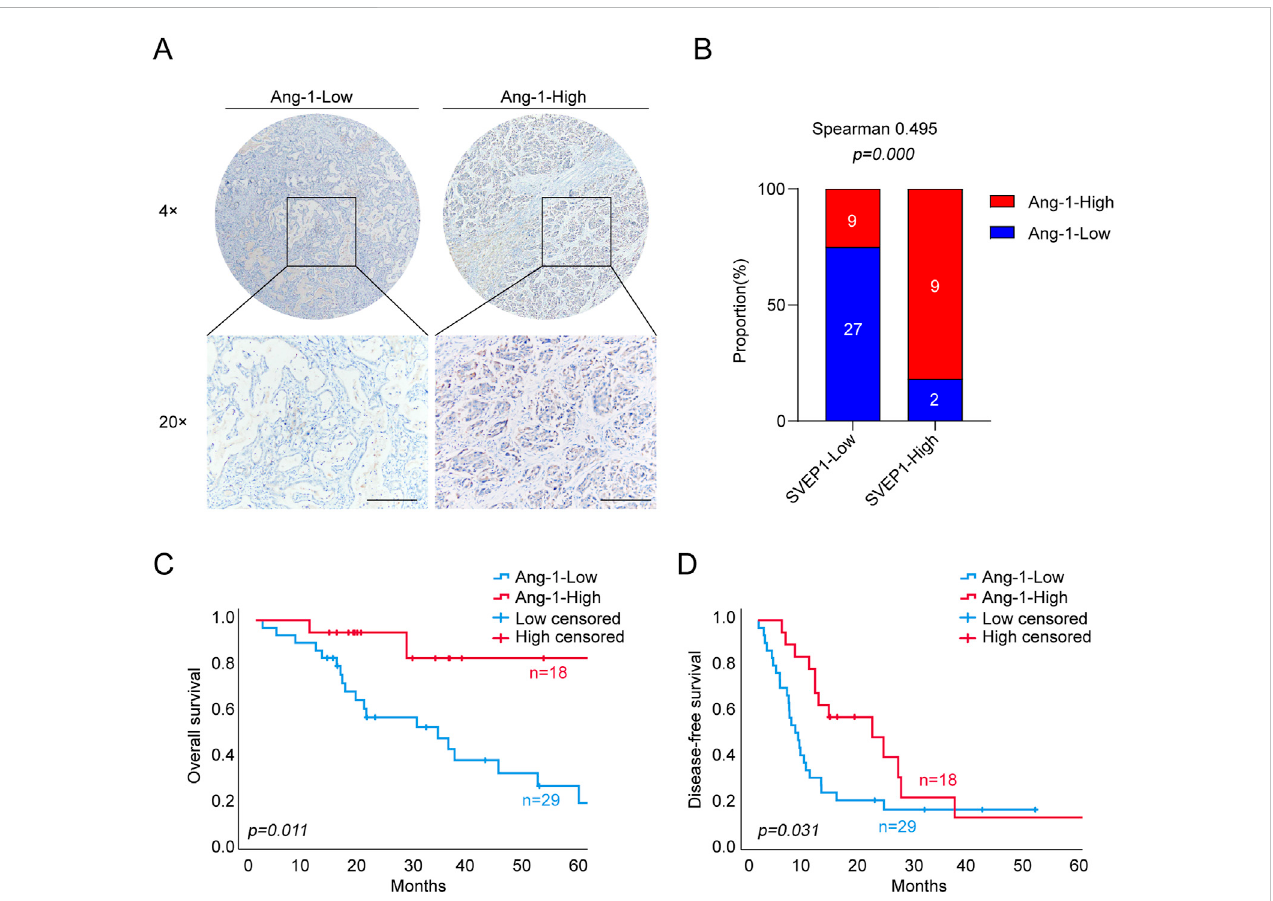
FIGURE 3 SVEP1expressionispositivelyrelatedtotheexpressionofAng-1,whichplaysanimportantroleinthemaintenanceofvascularstability. (A) Representative IHCimagesofAng-1inICCtissues. (B) IHCimagequanti fi cationresults.RelativeproportionsofhighandlowlevelsofAng-1inthegroupoftumortissueswith high and low expression of SVEP1, and the correlation analysis between Ang-1 and SVEP1. (C – D) Correlation of Ang-1 expression with the OS (C) and DFS (D) time of ICC patients,